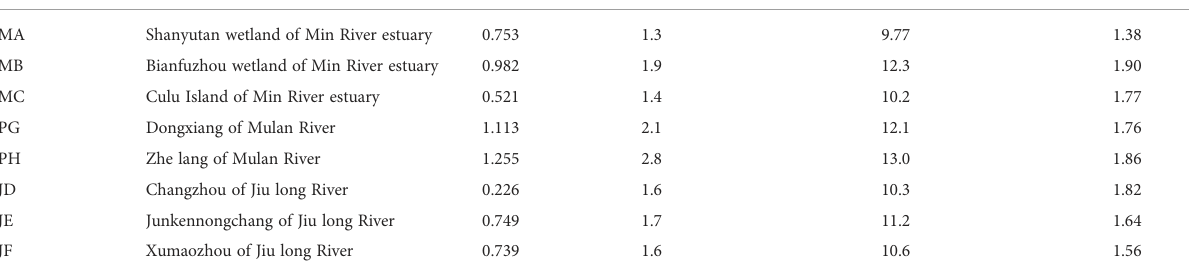
TABLE 2 Basic characteristics of all shrimp ponds in the estuaries of Fujian Province. Sampling